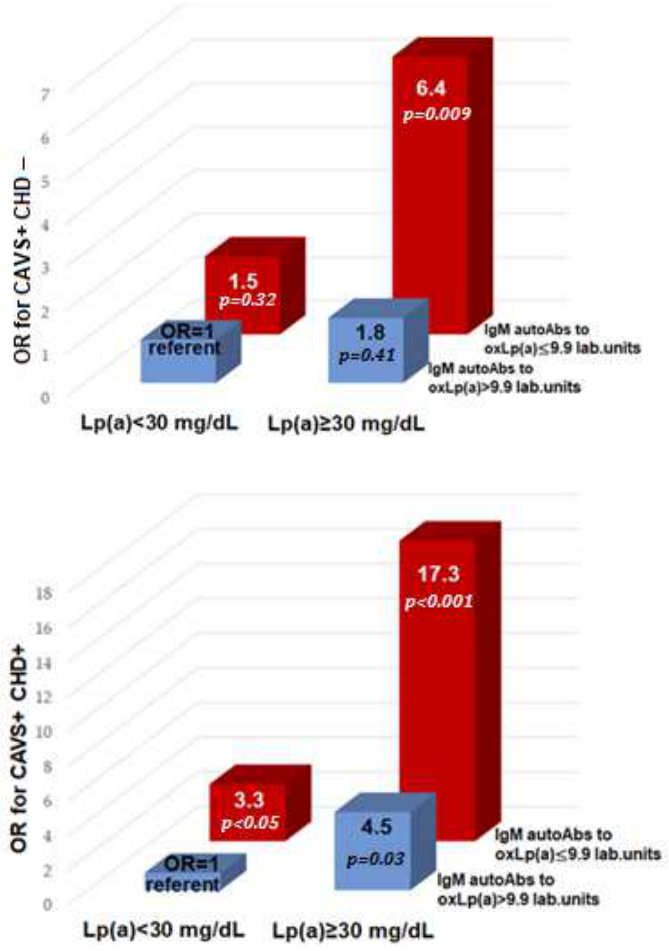
Figure 3. Odds ratio of calcific aortic valve stenosis and coronary heart disease depending on lipoprotein(a) and IgM autoantibodies to oxidative lipoprotein(a). OR—odds ratio; CAVS—calcific aortic valve stenosis; CHD—coronary heart disease; autoAbs—autoantibodies; Lp(a)—lipoprotein(a); oxLp(a)—oxidized lipoprotein(a).